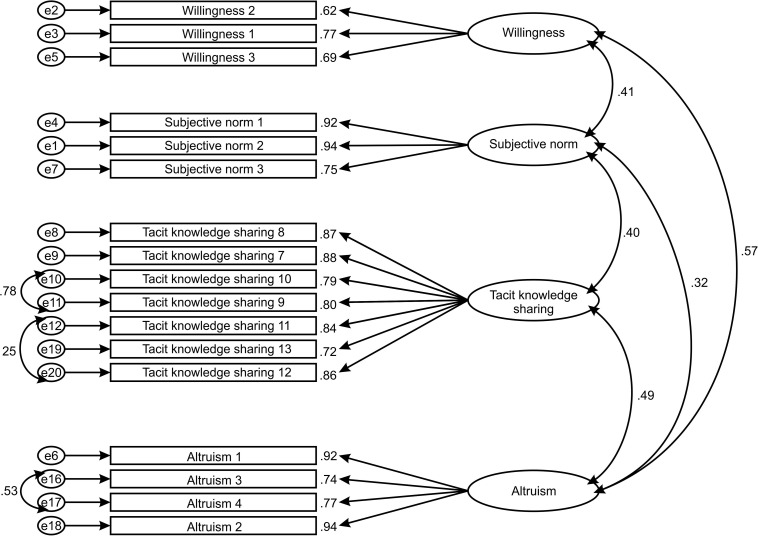
Measurement model.